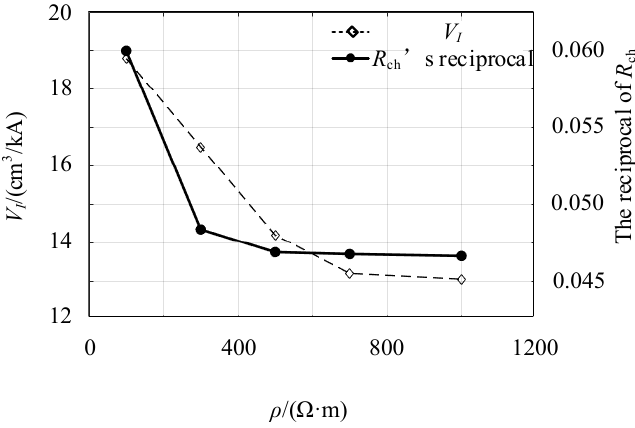
Figure 7. V I and reciprocal of R ch of different soil resistivity.